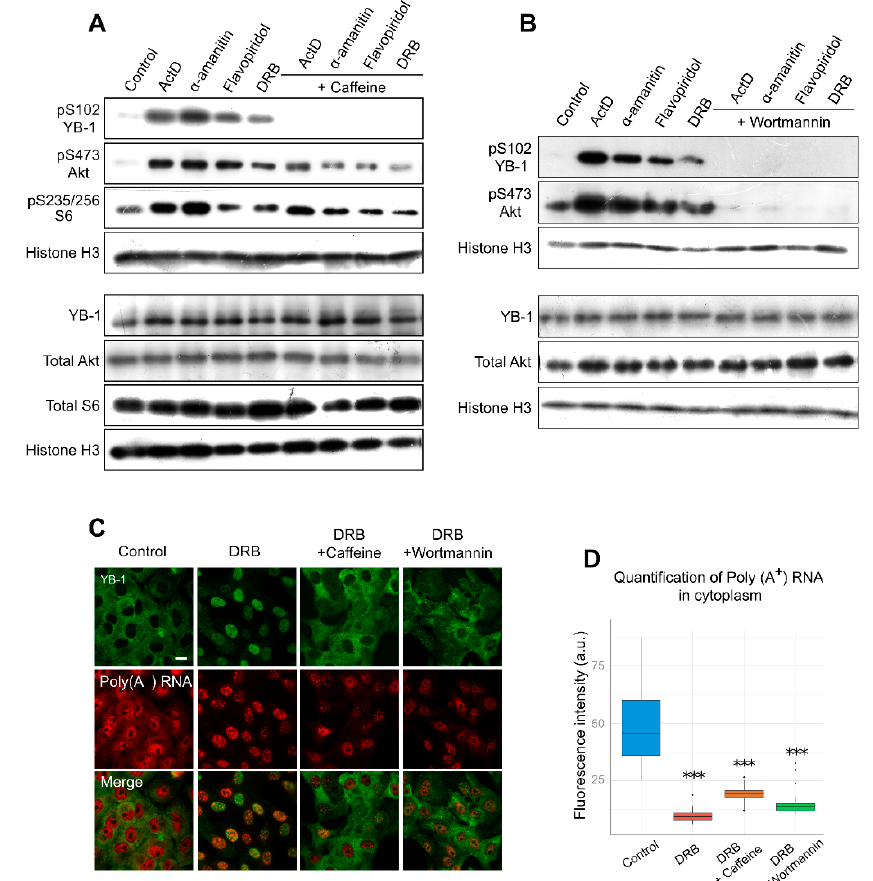
Figure 4. Inhibition of transcription entails YB-1 phosphorylation at Ser102. ( A , B ). Western blot of the whole extracts from Vero cells treated with ActD, flavopiridol, α -amanitin, and DRB for 24 h in the presence or absence of caffeine ( A ) or wortmannin ( B ). ( C ) Immunofluorescence microscopy of YB-1 and in situ hybridization of poly(A + ) RNA in Vero cells treated with DRB in the presence of caffeine or wortmannin. Scale bar 50 μ m. ( D ) Quantification of cytoplasmic poly(A + ) RNA in control cells or in cells treated with DRB alone or DRB together with caffeine or wortmannin. Results are mean ± SD. *** p < 0.001, paired t -test; n = 20 for each condition.